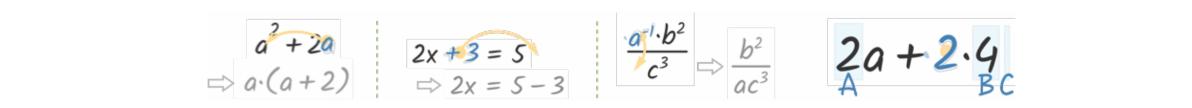
Frontiers in Education |